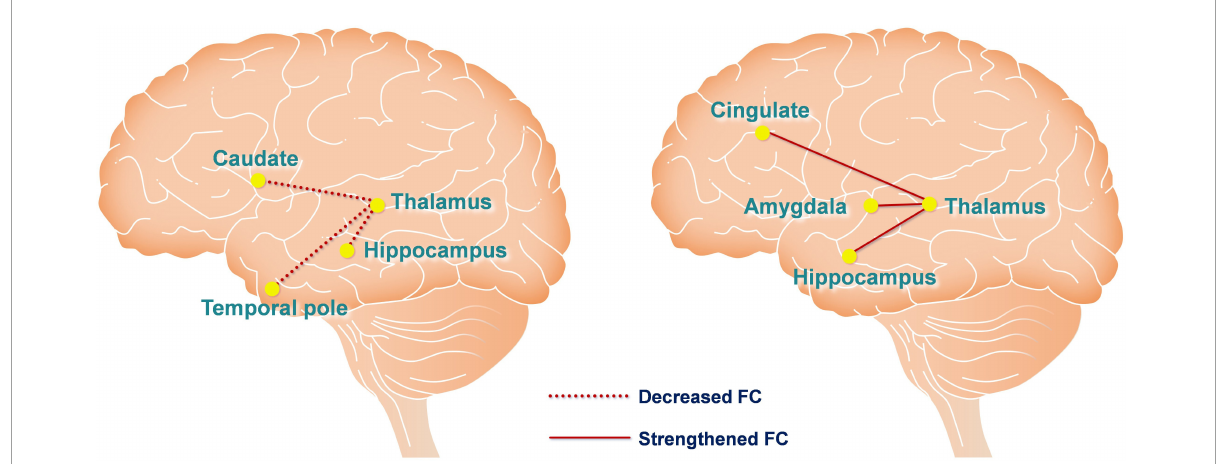
FIGURE5 Functional connectivity changes are caused by hypoxia and anodal tDCS. The left figure depicts hypoxia-induced FC changes of the thalamic network using the contrast of baseline > post-sham. The right figure depicts anodal tDCS-induced FC changes of the thalamic network in the hypoxia environment using the contrast of post-tDCS > post-sham. The red dashed and solid lines represent decreased and increased FC, respectively.